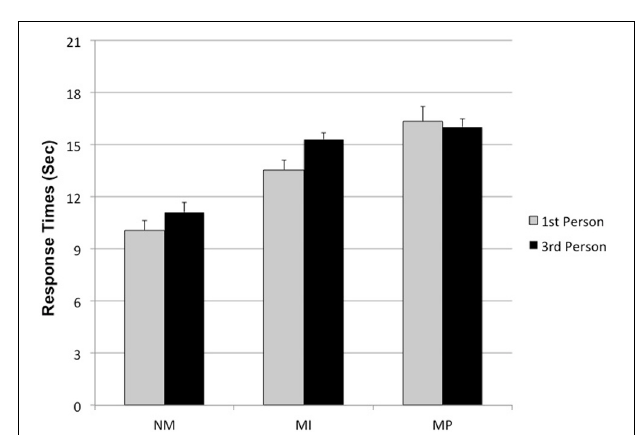
FIGURE 3 | Condition × Perspective interaction on Response time. (NM, Non Moral; MI, Moral Impersonal; MP, Moral personal).